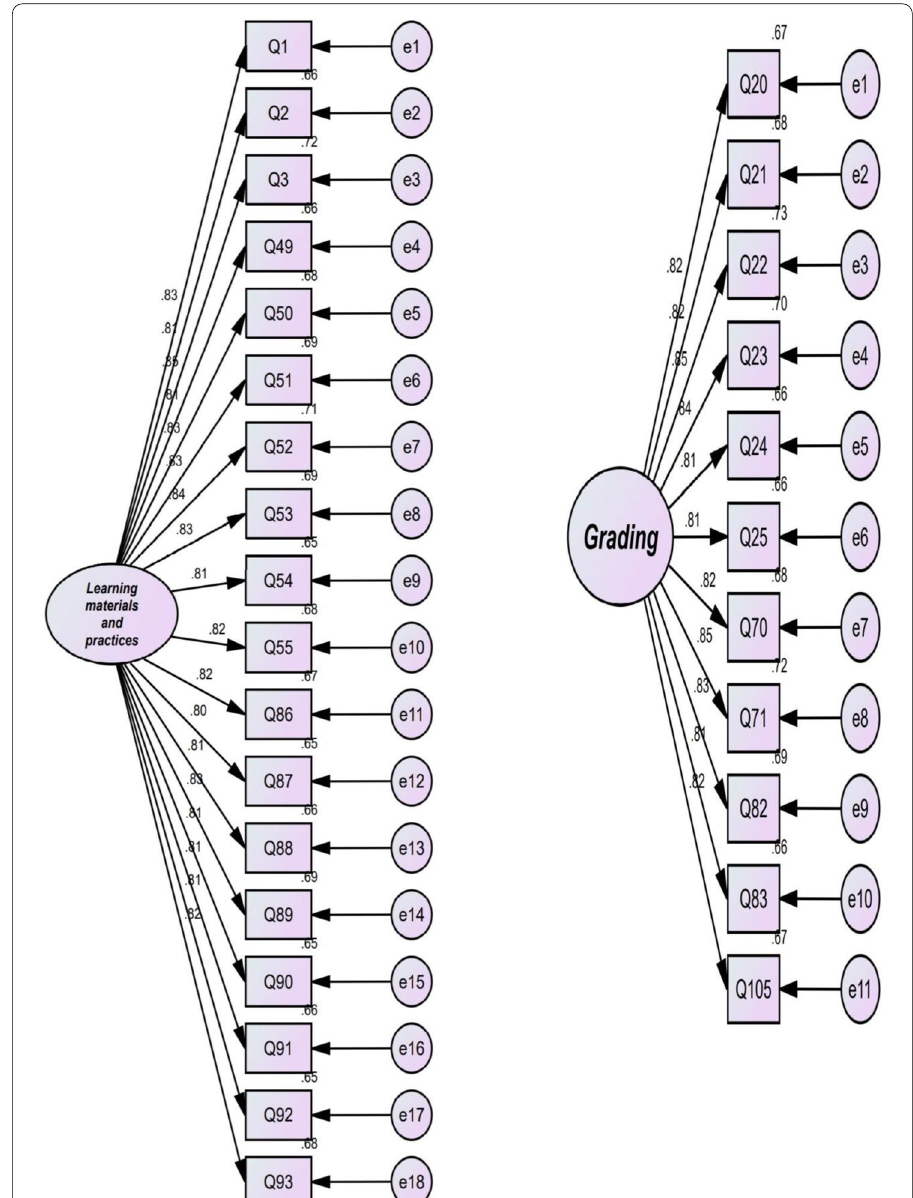
Fig. 1 Structural model of the TF showing latent and observed variables and measurement